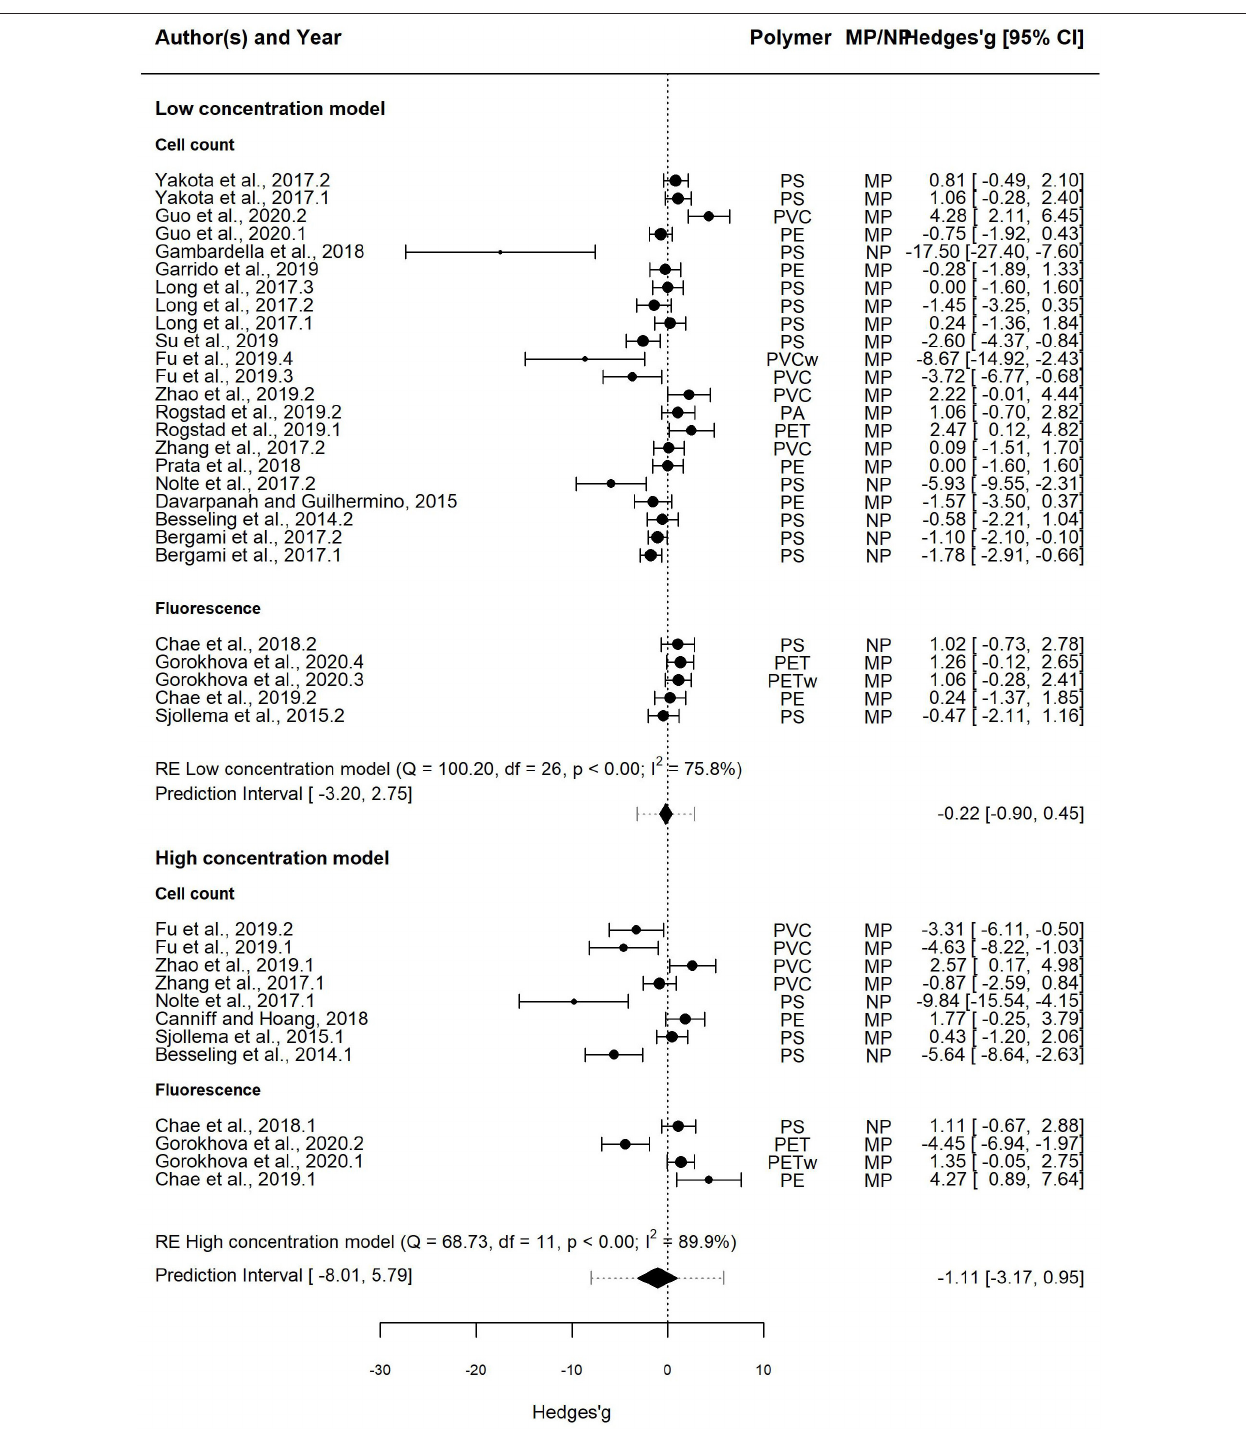
Frontiers in Environmental Science |